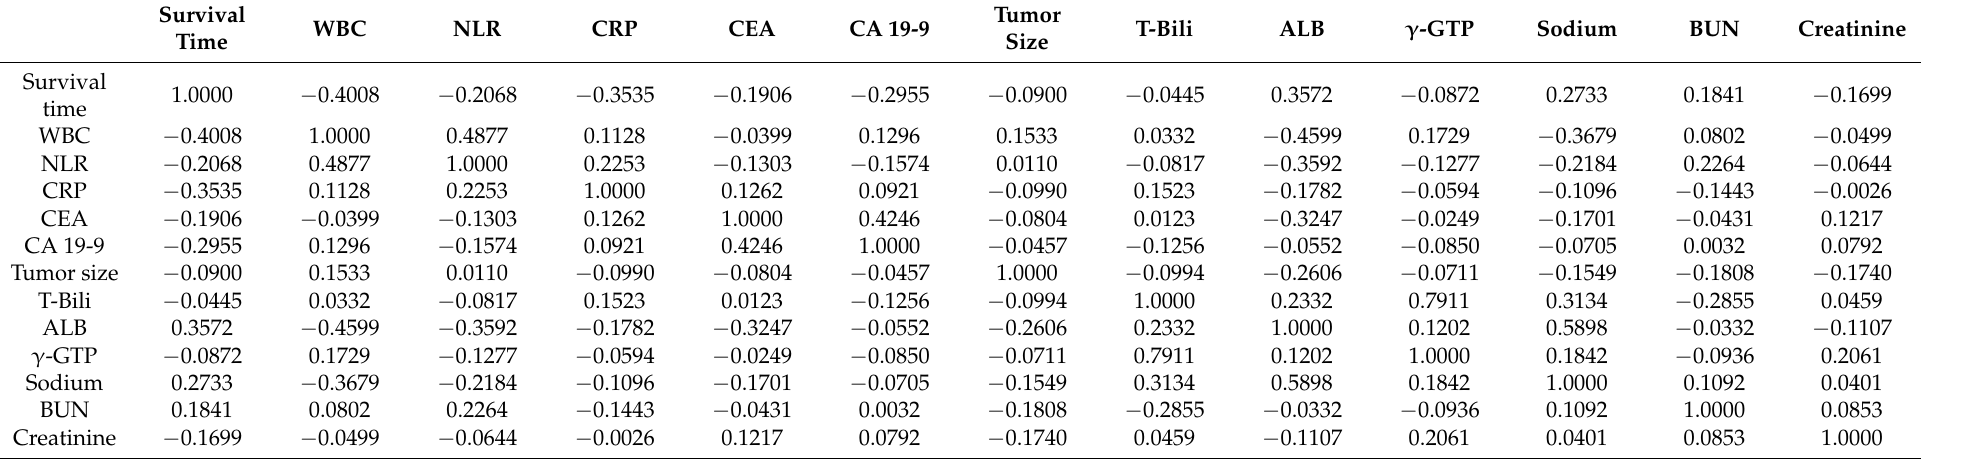
Table 2. Multivariate correlation analysis of overall survival showing serum albumin level was positively correlated with